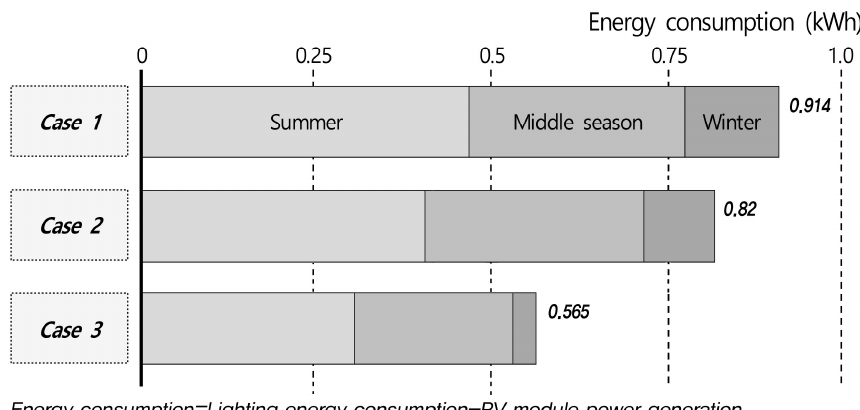
Figure 13. Energy consumption analysis (by